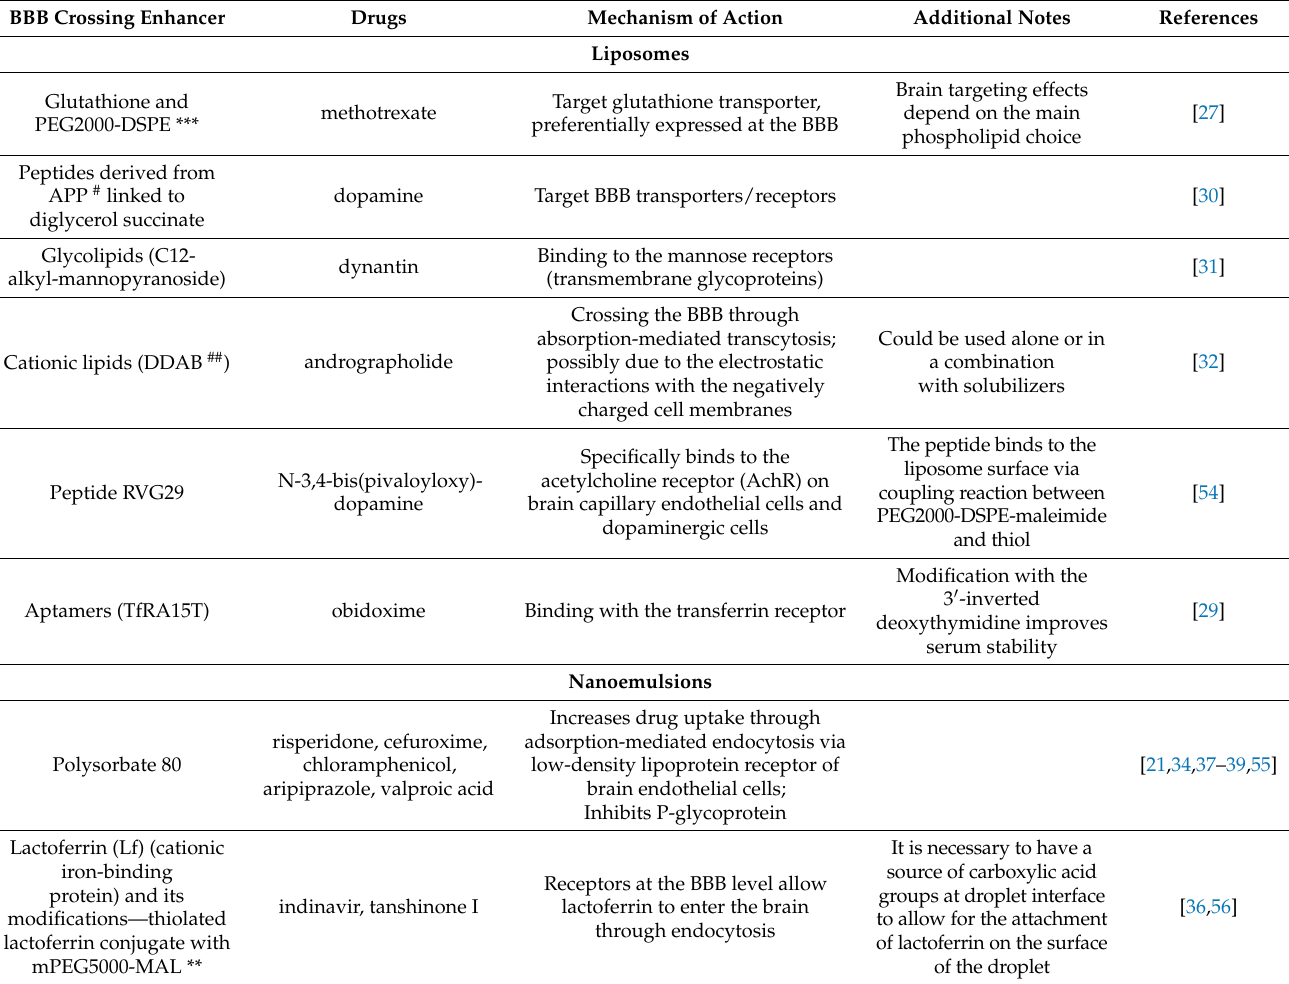
Table 1. Brain-targeting ligands in lipid